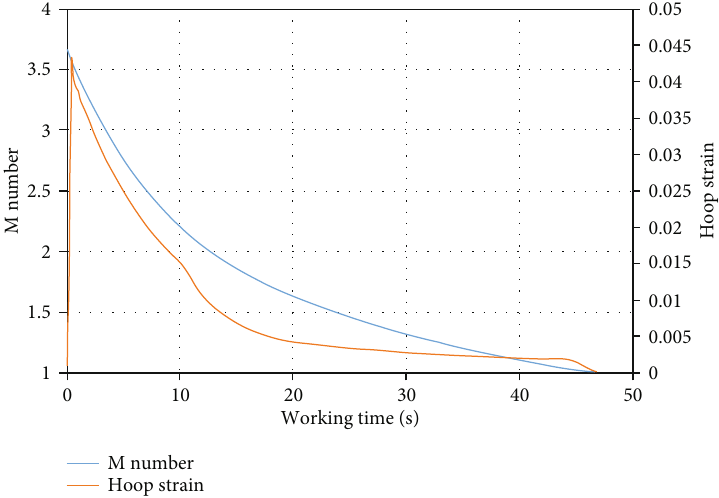
Figure 7: The change of m number and the hoop strain of inner hole over time.